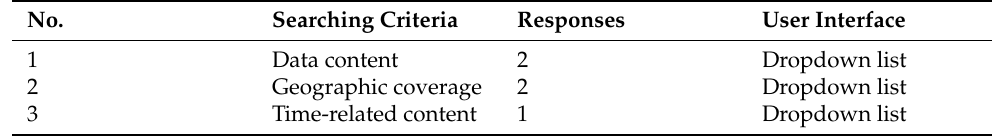
Table 5. Novice participants’ preferred interface for spatial data